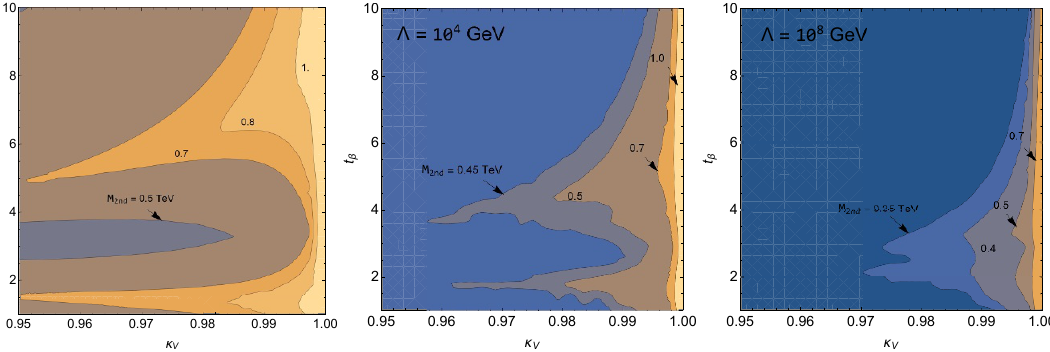
Figure 3 . Contour plots for the maximally allowed value of M 2nd = Min( m 2HDMs obtained by imposing Bound A (left), Bound B with Λ = 10 4 GeV (center) and Bound B with Λ = 10 8 GeV (right) on the κ